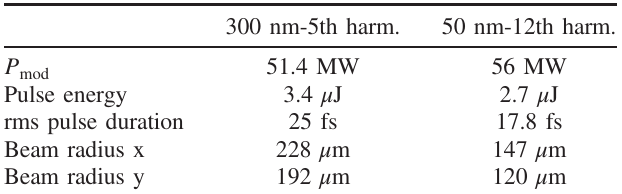
TABLE V. Summary of laser pulse properties at the exit of the modulator.